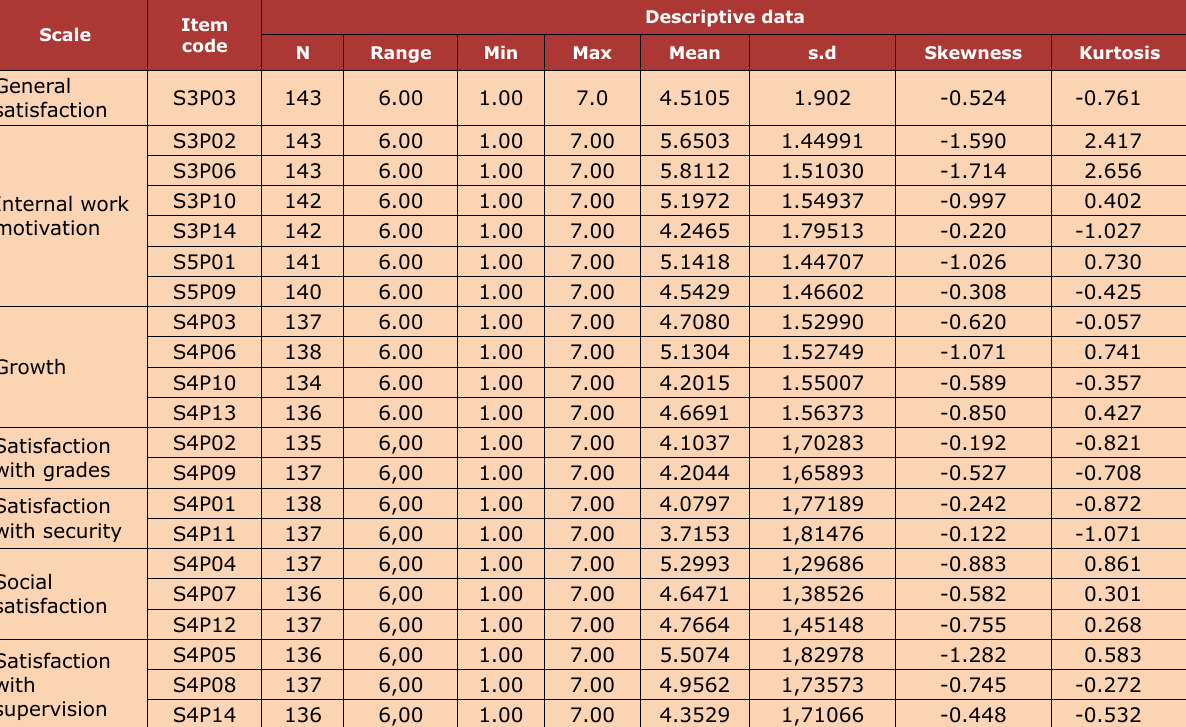
Table 3. Satisfaction scales Descriptive statistics